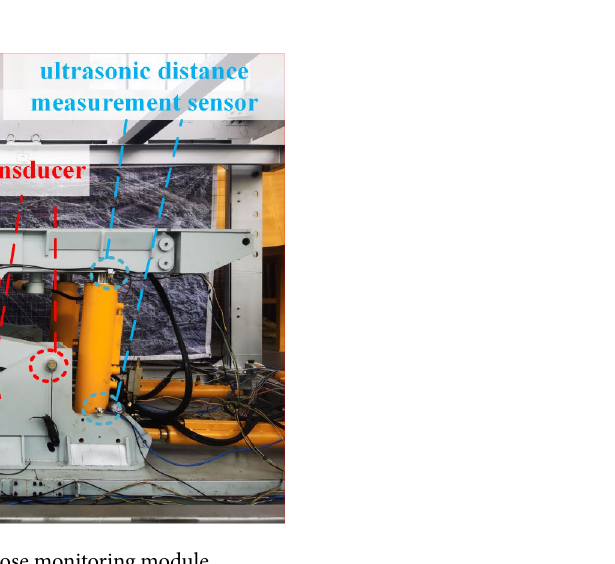
Figure 16. Installation layout of the pose monitoring